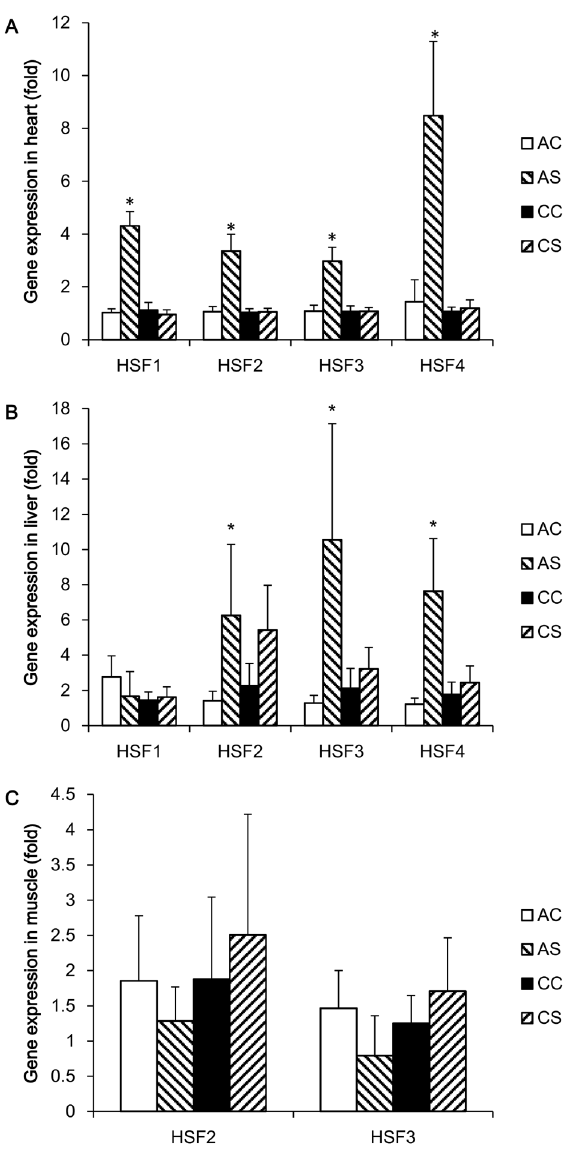
Figure 5. Normalized gene expression of HSP 70 and 90 after acute and chronic heat challenges. Expression of HSP 70 and 90 genes was determined by real time PCR using SYBR green dye and the 2 2 DD Ct method was used to calculate mRNA level of each gene, where the average mean of the unstressed group was used as the calibrator. Each PCR reaction was conducted in triplicate and the geometric mean of internal references, b -actin and GAPDH, was used to normalize the expression of targets genes. Values are expressed as means 6 SE of data from 5–6 individual tissue samples. * indicates significant differences (P , 0.05) between controls and heat -stressed groups. AC, acute heat control group; AS, acute heat-stressed group; CC, chronic control group; CS, chronic heat-stressed